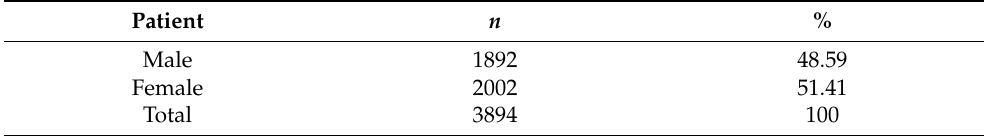
Table 2. Shows the number of patients who have used the application.